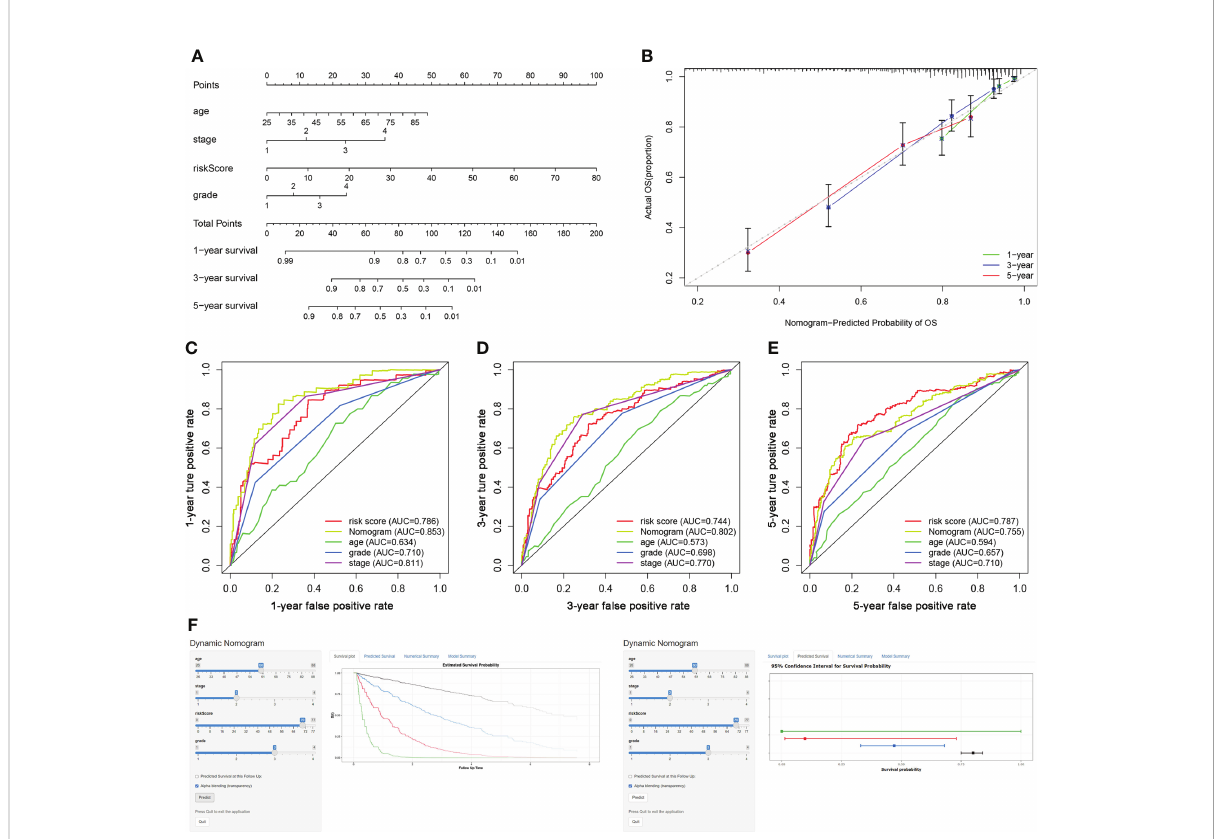
FIGURE 5 Construction of a TIL-related lncRNA prognostic model to predict survival. (A) The nomogram of 1-year, 3-year, or 5-year OS. (B) Calibration plots for evaluating the agreement between the predicted and the actual 1-year, 3-year, and 5-year OS for the prognosis model. (C – E) The 1- year, 3-year, and 5-year ROC curves of the nomogram and other clinicopathological parameters. (F) A dynamic nomogram for clinical application to predict survival. The K – M analysis is shown on the left. The corresponding 95% CI is shown on the